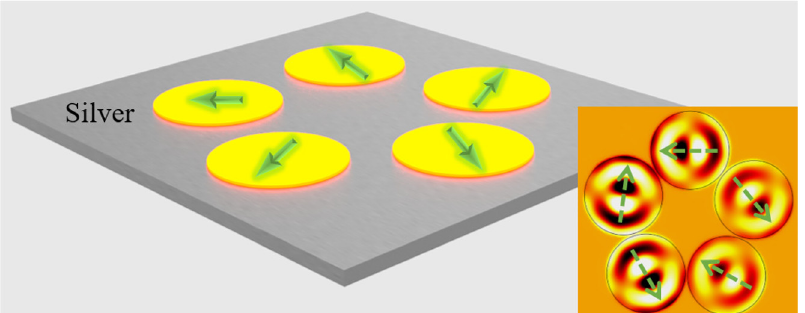
Figure 1: A schematic picture of an array of N (cid:1) 5 metallic nanodisk lasers used in this study. The green arrows depict the orientation of the pseudospins. The inset shows lasing mode of a fi ve-element nanodisk laser array as obtained from FEM simulations. The rotation of the local reso- nant modes is illustrated with dashed ar- rows, indicating the pseudospins.